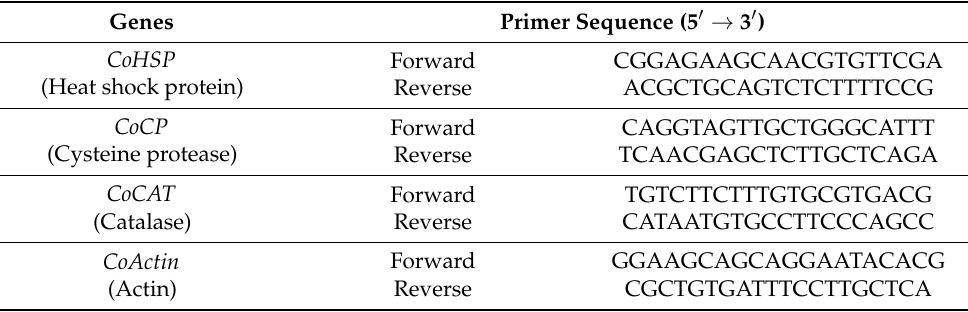
Table 2. Primers for analysis of heat tolerance gene expression in Cnidium officinale . Genes Primer Sequence (5 (cid:48) → 3 (cid:48)